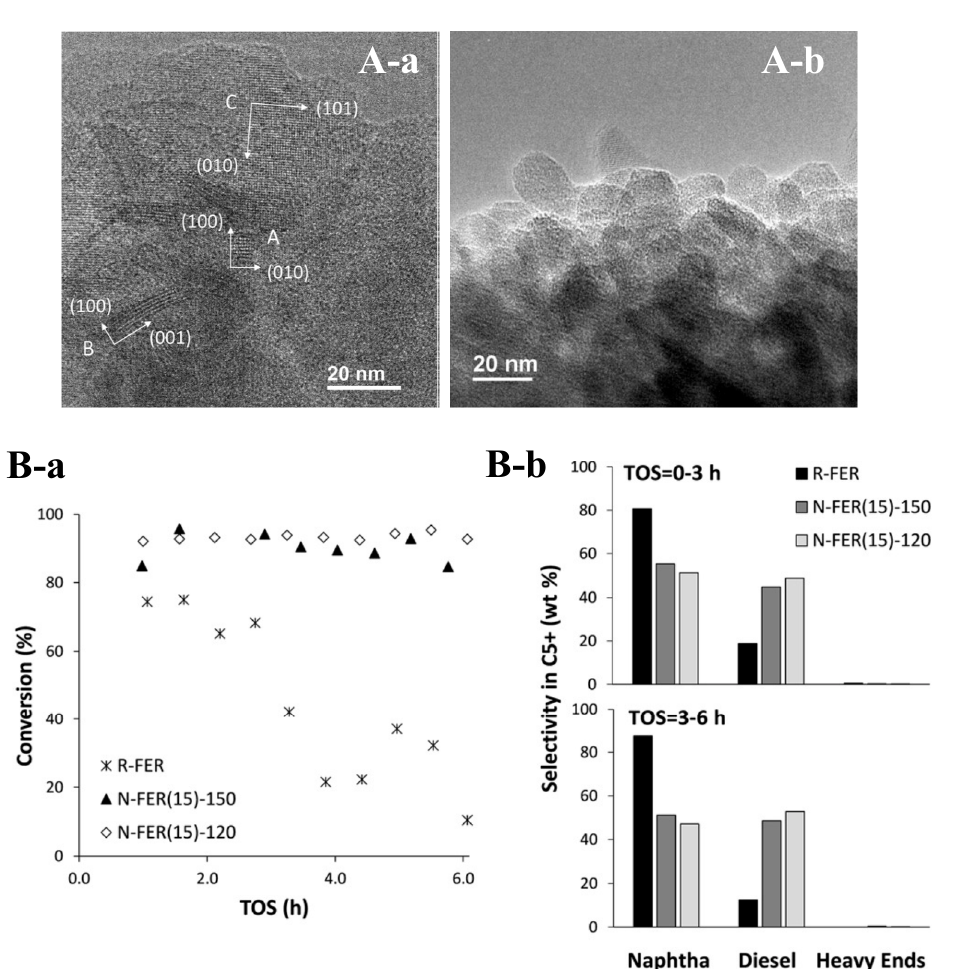
Figure 4. ( A ) TEM images of aluminosilicate FER zeolite nanocrystals synthesized with Si / Al molar ratios of 15 at ( a ) 150 ◦ C and ( b ) 120 ◦ C, respectively. ( B ) Catalytic performance including ( a ) 1-pentene conversion versus time on stream (TOS) and ( b ) selectivity within the C 5 + liquid fraction in oligomerization of 1-pentene to liquid fuels reactions over aluminosilicate FER zeolite: R-FER (reference FER zeolite synthesized using Pi as a single OSDA), N-FER(15)-150 and N-FER(15)-120 (FER zeolite nanocrystals synthesized with Si / Al molar ratios of 15 at 150 ◦ C and 120 ◦ C). Reprinted with permission from ref. [7]. Copyright 2018, Wiley.